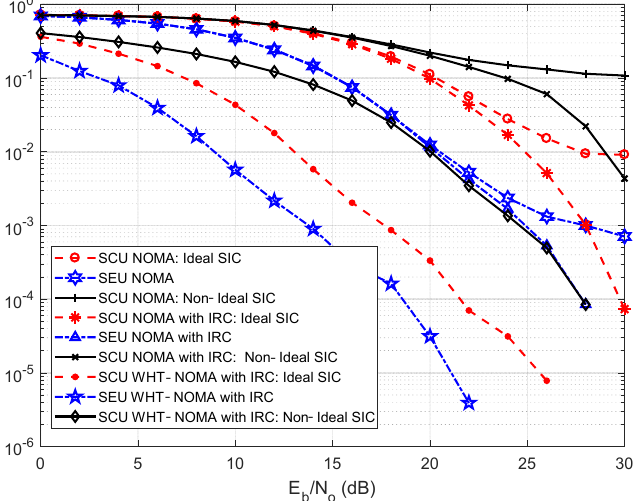
Figure 14. BER performance with IRC using BPSK modulation; NOMA vs. WHT–NOMA, power allocation: SCU = 0.2 and SEU = 0.8.